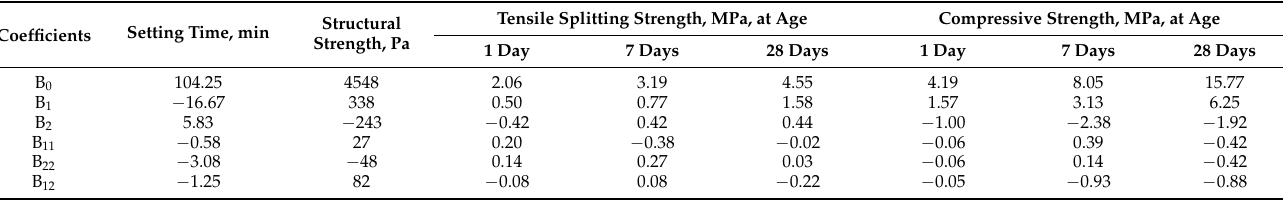
Table 8. Coefficients of regression equations.